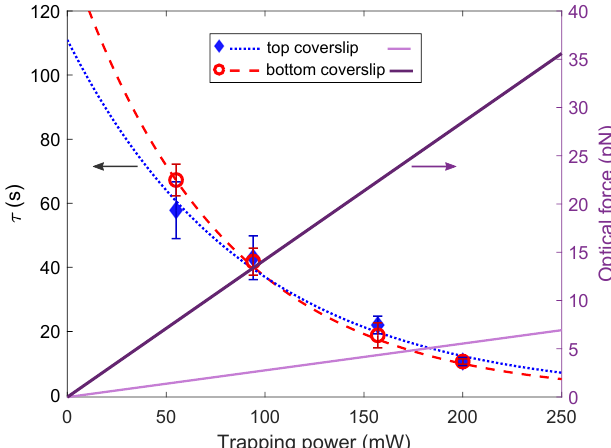
Figure 4. Detachment time τ (left vertical axis) and optical forces (right vertical axis) of the Dunaliella adhered to top or bottom coverslips as a function of the trapping power. The filled diamonds correspond to the detachment time from the top coverslip, and the open circles to the detachment time from the bottom coverslip. The dashed lines are the least squares fits to decaying exponential obtained using the Levenberg-Marquardt algorithm. The solid lines (dark and light) are the optical forces exerted to the cells attached to the bottom and top coverslips,